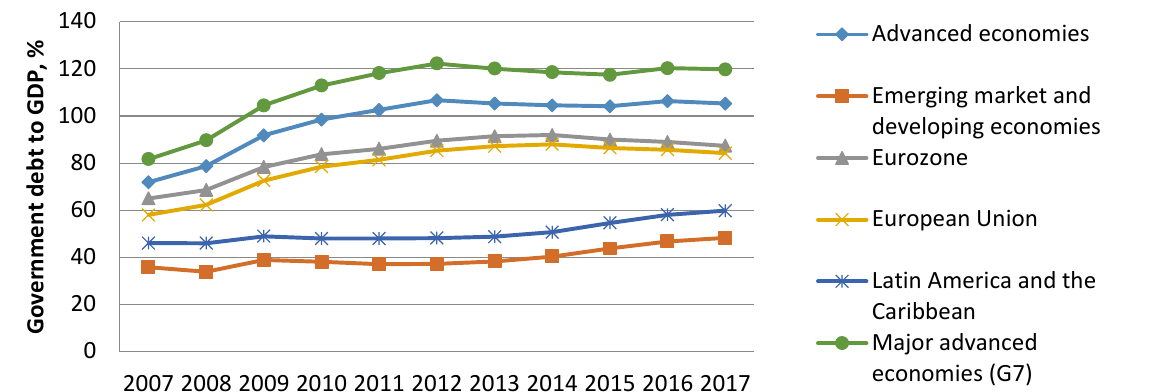
Source: International Monetary Fund